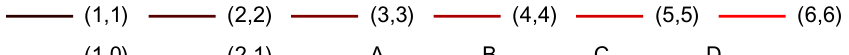
( L, δ ) . For the legend, see 2